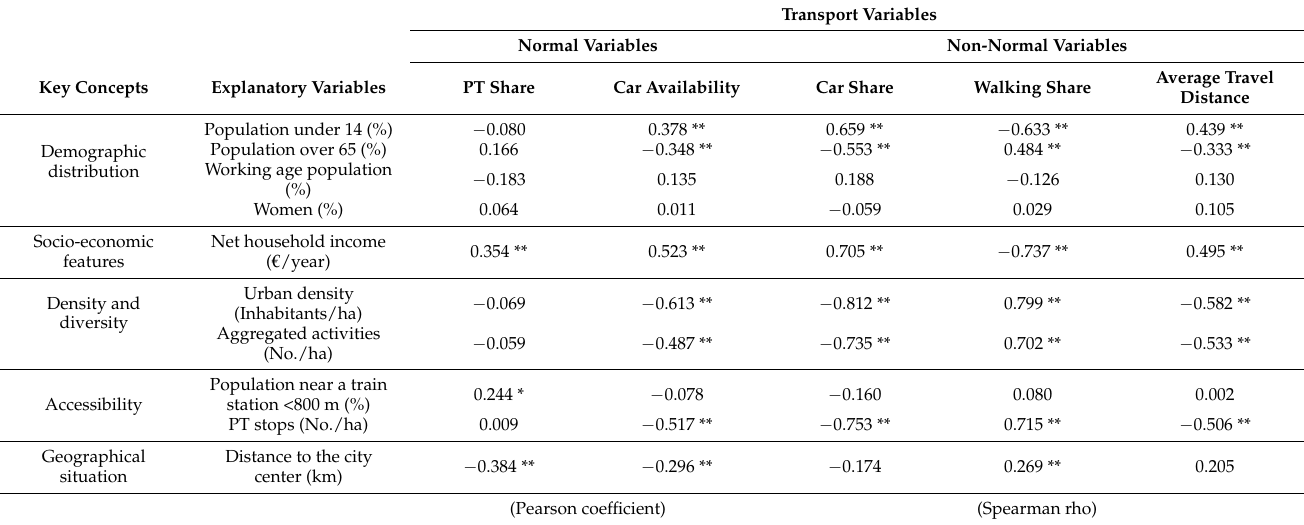
Table 5. Correlation coefficients between transport variables and explanatory